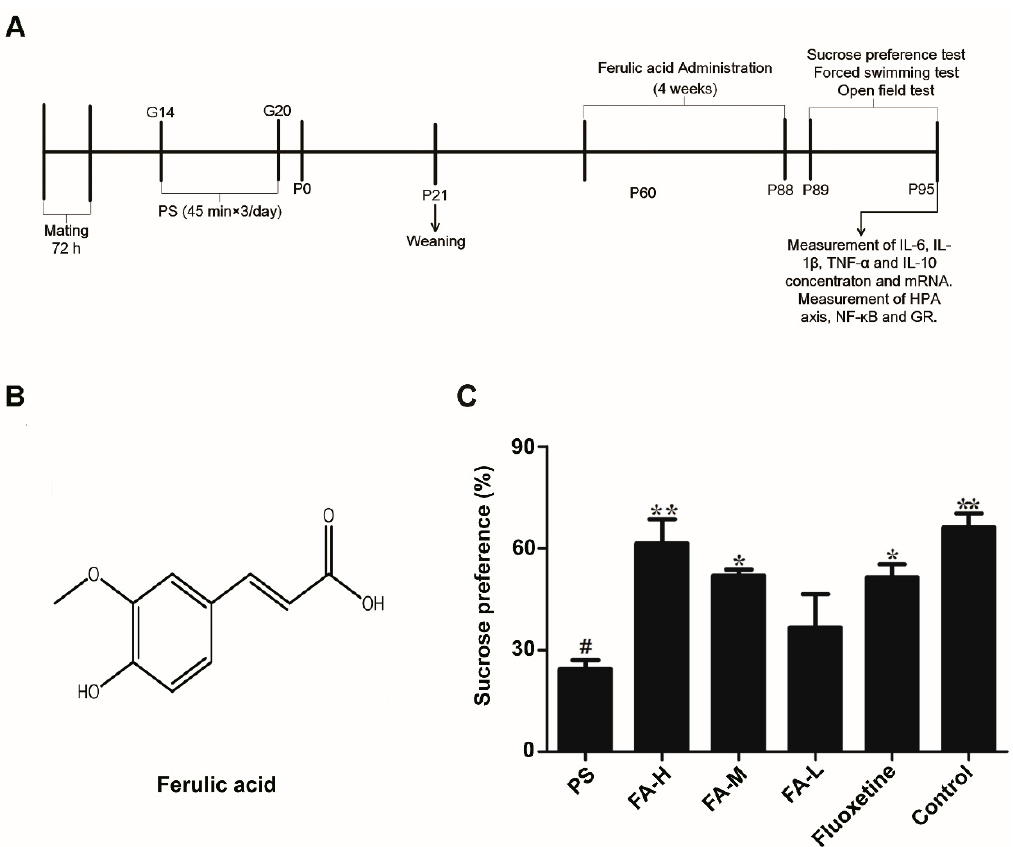
Figure 1. Chemical structure and effects of ferulic acid (FA) on the sucrose preference in offspring rats exposed to prenatal stress. ( A ) Timeline showing a summary of the experimental design. G: gestational age; P: postnatal age (days). PS: prenatal stress; ( B ) Chemical structure of FA; ( C ) Effects of FA on the sucrose preference. The percentage of sucrose consumed at sucrose concentrations of 2%. Values represent means ± SEM ( n = 8). * p < 0.05 and ** p < 0.01 compared with PS group, # p < 0.05 compared with Control group. FA-L: FA at low 12.5 mg/kg/day, FA-M: FA at medium 25 mg/kg/day, FA-H: FA at high 50 mg/kg/day.